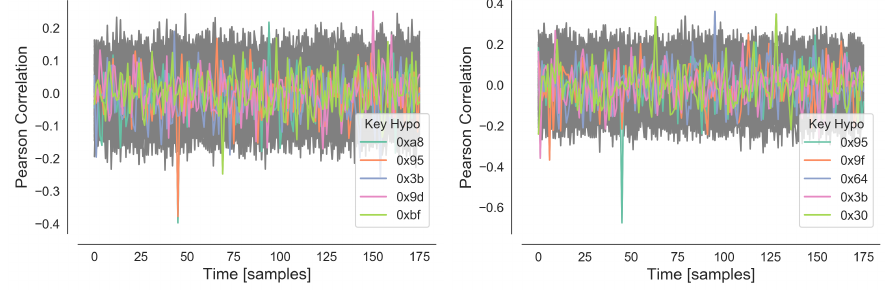
Figure 11: Pearson Correlation coefficients in Step 3 with N 15 = 0x80 and SNR=1.0 with 256 traces (left) and 128 traces